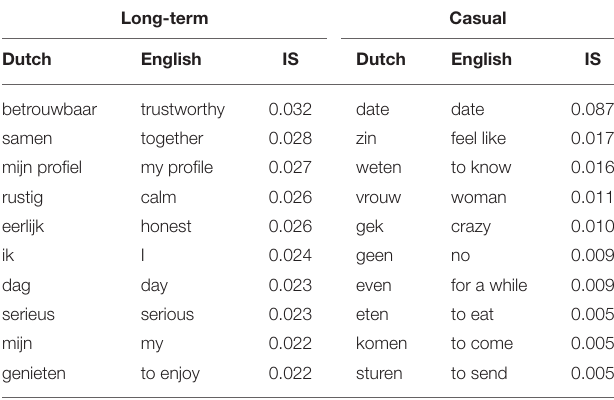
TABLE 3 | Top 10 most important content-specific features with the importance score (IS) per relationship seeking group. Long-term